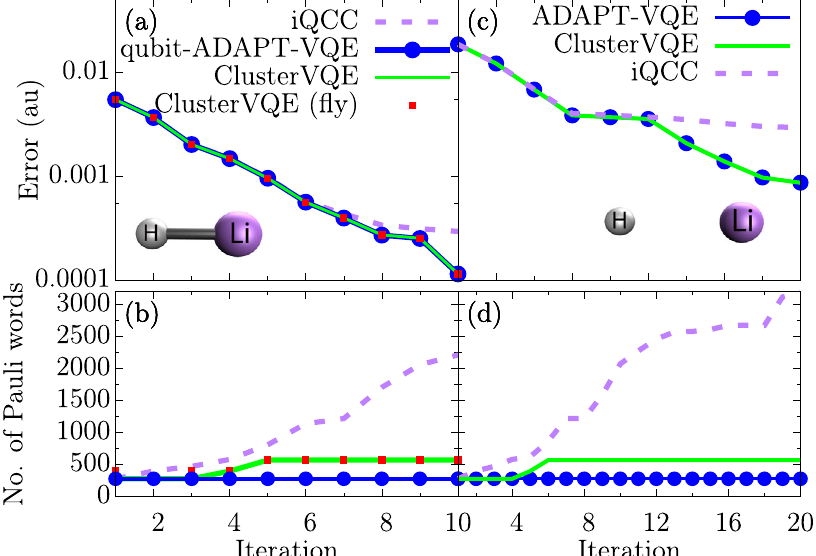
Fig. 1 Simulation of LiH molecule. a , c GS Energy errors and ( b , d ) number of Pauli words per each iteration for the LiH molecule obtained from the qubit-ADAPT-VQE, iQCC, and ClusterVQE algorithms. The Li-H bond lengths are 1.547 Å ( a , b ) and 2.4 Å ( c , d ),